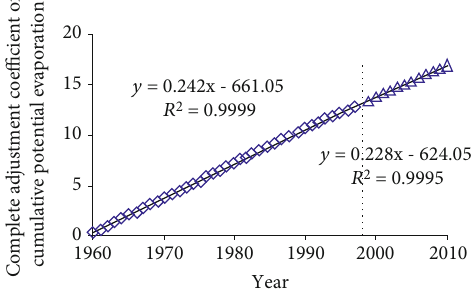
Figure 10: Complete adjustment coe ffi cient of cumulative potential evaporation.